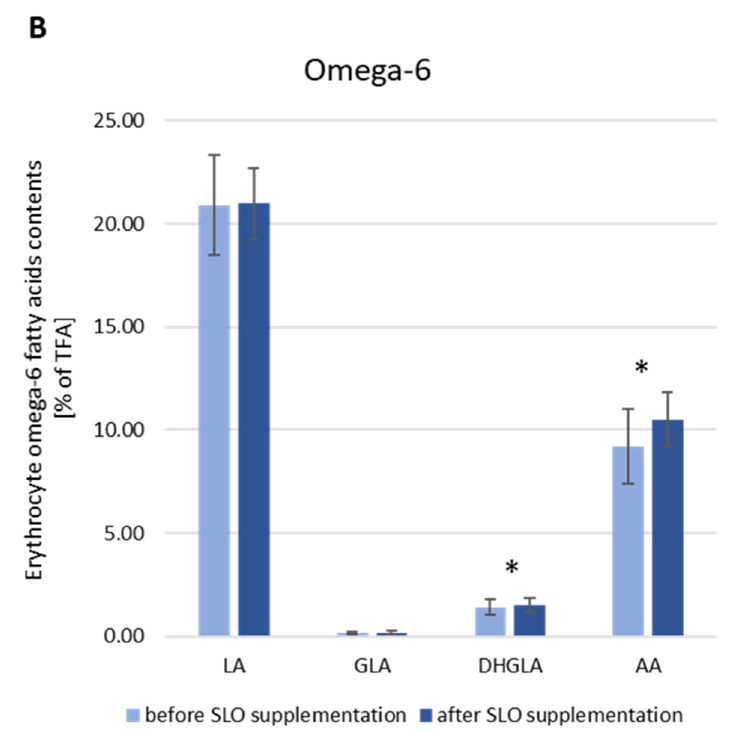
Figure 3. The erythrocyte content of omega-3 FAs ( A ) and omega-6 FAs ( B ) in study participants before and after 6 weeks of SLO supplementation. Data are represented as media ± SD in n = 27 subjects. Statistical analysis was performed by paired Student’s t-test (LA, DHGLA, DHA) or Wilcoxon matched-pairs signed rank test (EPA, DPA, ALA, GLA, AA). * p < 0.05 was considered to be statistically significant.